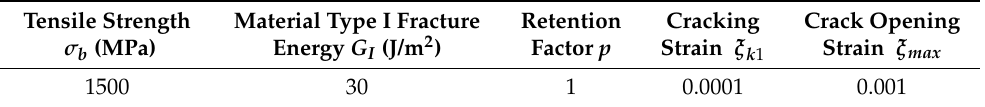
Table 4. SiC brittle fracture